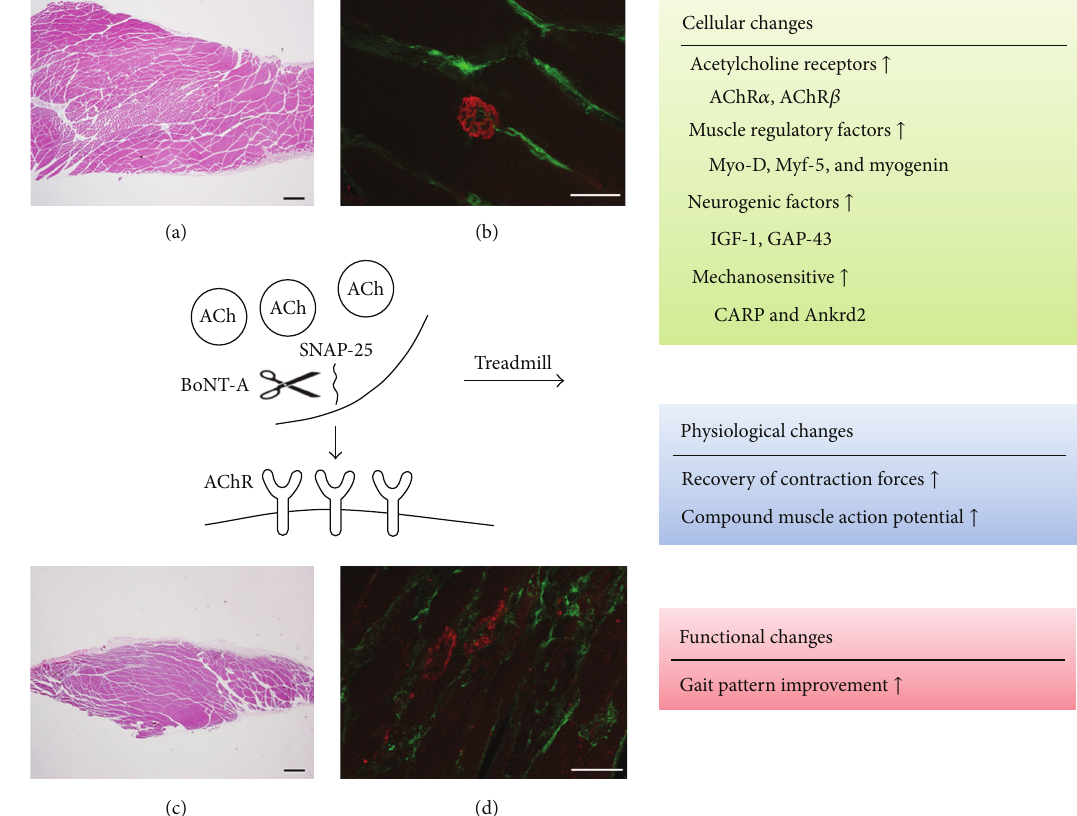
Figure 1: The influence of treadmill exercise on muscle activity and NMJ following BoNT - A injection . Representative pictures of H&E staining of (a) the normal architecture of the gastrocnemius without botulinum toxin injection and (c) atrophy in the gastrocnemius muscle 4 weeks after botulinum toxin injection. Immunohistochemistry staining of neuromuscular junction (NMJ) receptors of (b) the normal configuration of NMJ and (d) changes in the NMJ 4 weeks after BoNT-A injection. A widening of the NMJ (which loses its normal configuration), as well as the diffuse extrajunctional staining of acetylcholine receptors, was noted. Red: NMJ receptors. Green: neurofilament. Scale bar = 50 𝜇